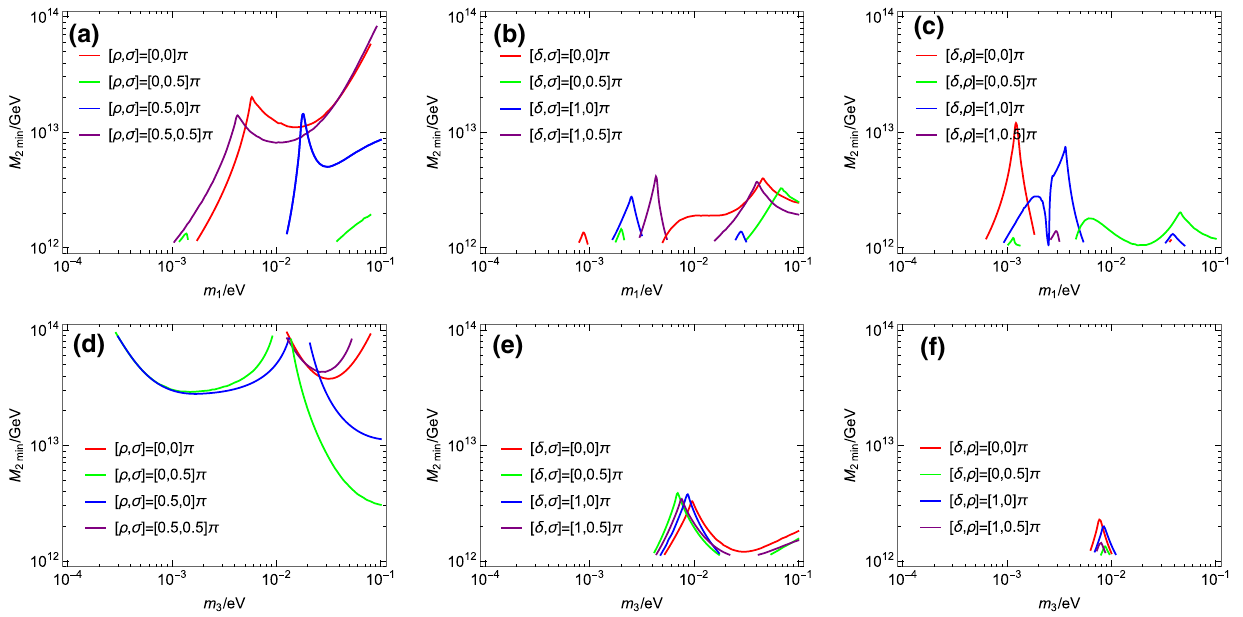
to be successful. These results are obtained by allowing δ to vary in the whole range. Second (third) column: same as the first column, except that the roles of δ and ρ ( σ ) are